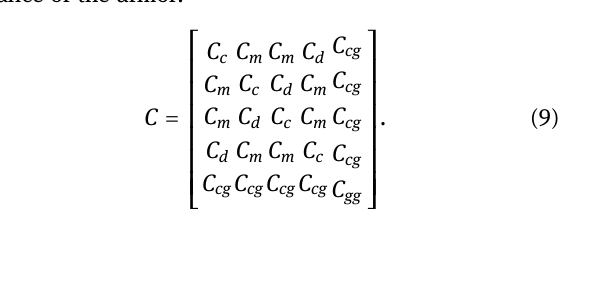
where V P signi fi es voltage of phase P with respect to ground. Here for this case, armor is grounded.